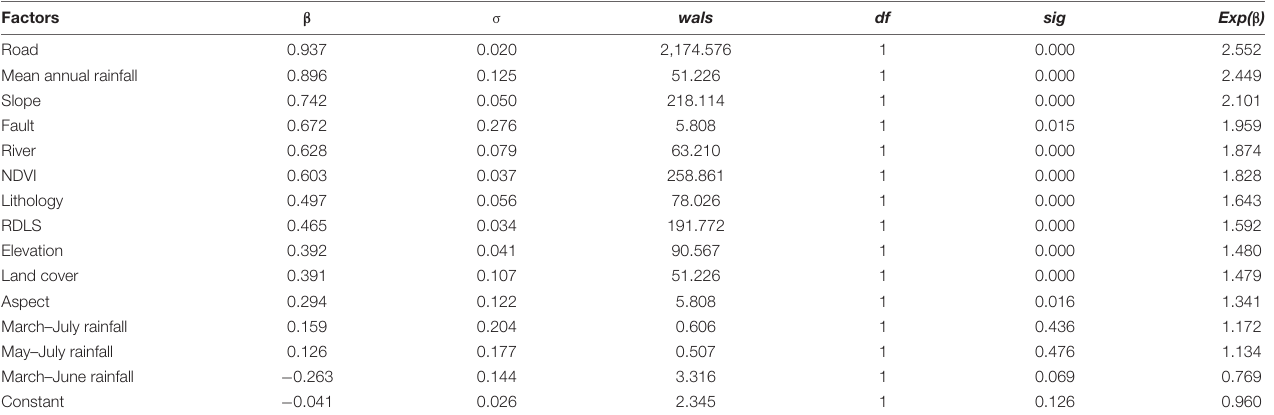
TABLE 5 | Results of logistic regression modeling with complete linear features (Model